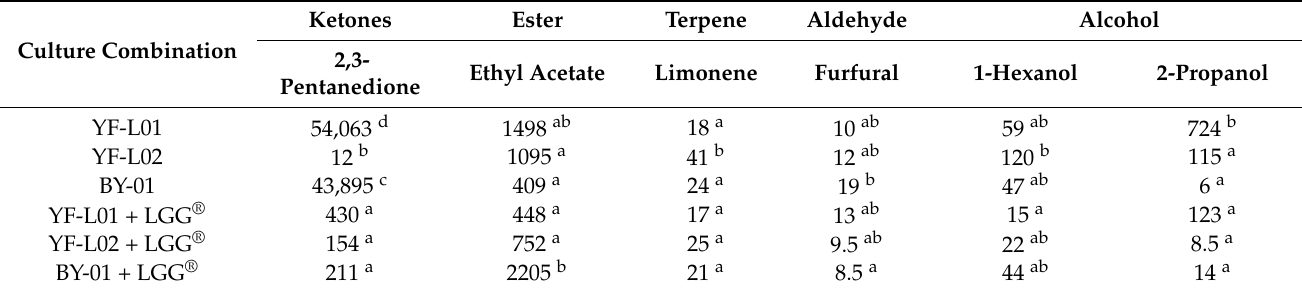
Table A4. Fermented oat samples.